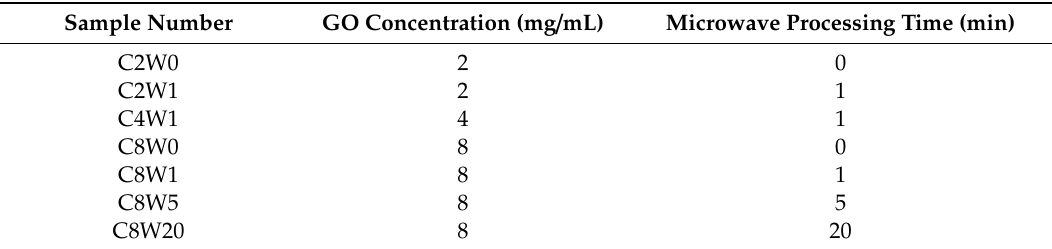
Figure 1. Schematic diagram of Anisotropic Chemically Derived Graphene Aerogels (AGAs) preparation steps. A digital image of the AGA's longitudinal section ( a ) and a digital image of the AGA's cross section ( b ); a digital image of the AGA before and after microwave treatment ( c ). Table 1. Sample Numbers for di ff erent graphene oxide (GO) concentrations and microwave treatment